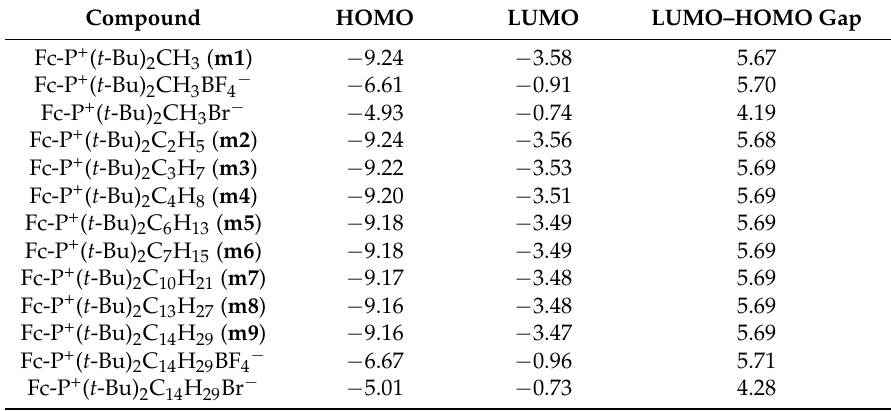
Table 7. Absolute HOMO and LUMO energies and HOMO–LUMO gaps (in eV) calculated for the models m1 – m9 a .